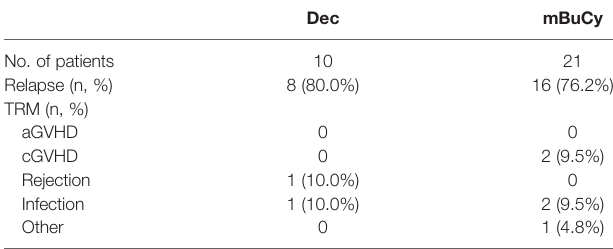
TABLE 3 | Primary causes of death in the study cohort.